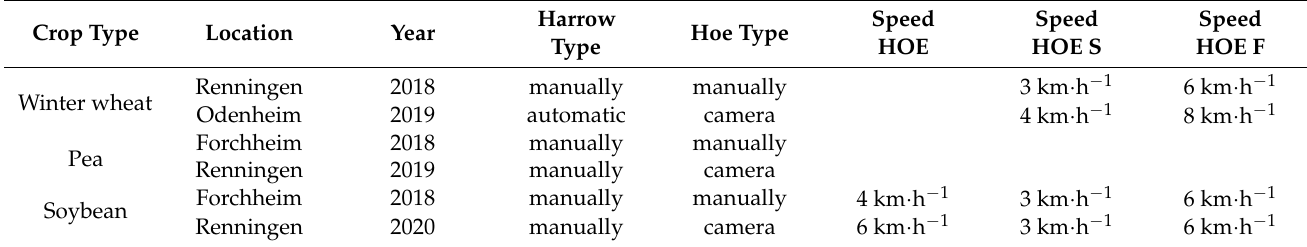
Table 3. Hoe types and driving speeds for different hoeing treatments.